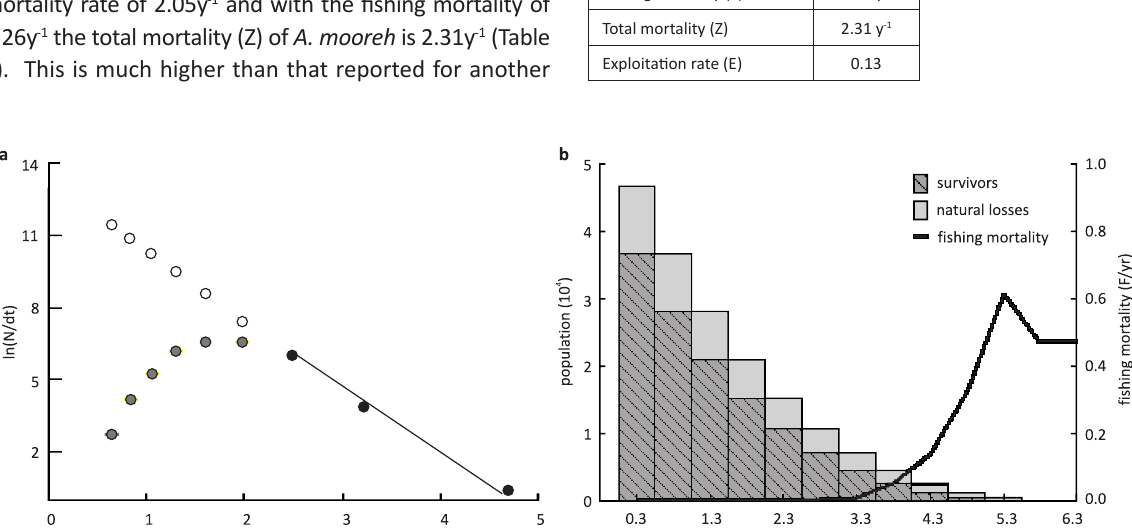
Figure 3. Mortality parameters for the population. (a) Length converted catch curve and (b) length structured virtual population analysis.